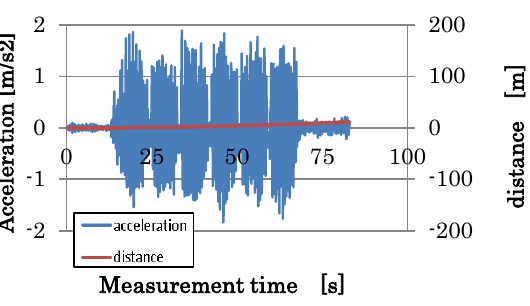
Fig. 11 Y-axis acceleration and position of IMU